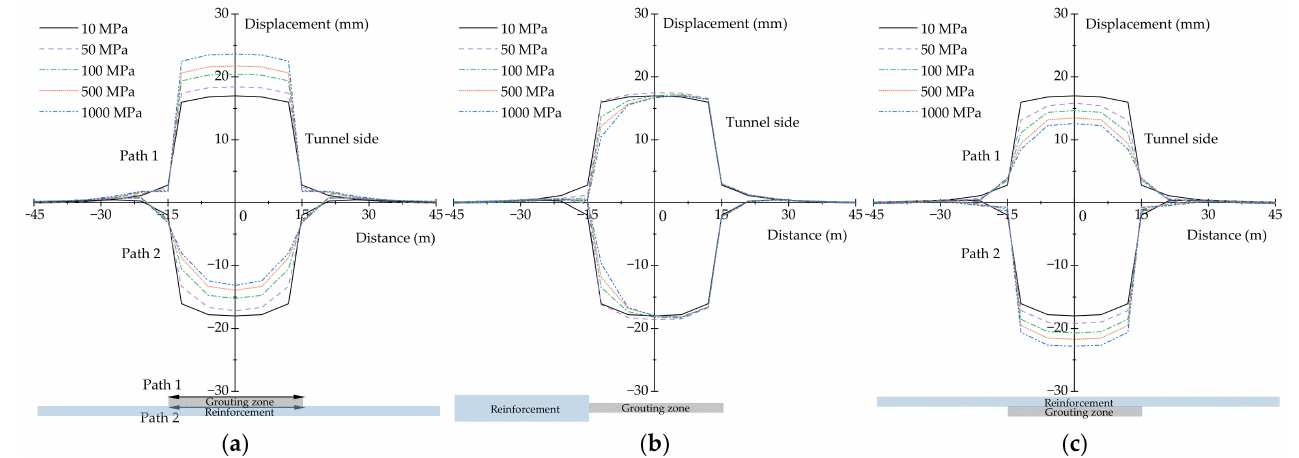
Figure 11. Soil displacement of the grouting zone. ( a ) Case 1; ( b ) Case 2; ( c ) Case 3.